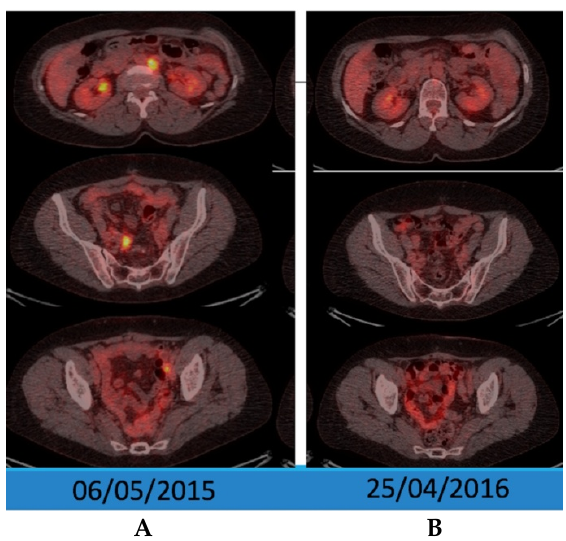
Figure 4. F18-FDG PET/CT scans—2015, before chemotherapy and 2016, after treatment, evaluating the therapy response: axial section abdominal level (upper images), pelvic level with right lymph node (middle image), and pelvic level with left lymph node (lower image), showing tracer high uptake in left abdominal latero-aortic lymph node (SUVlbmMax—5.1), and in bilateral pelvic lymph nodes (( B ) SUVlbmMax—4.8 and ( A ) SUVlbmMax—3.9), with complete remission in 2016 on all sites.